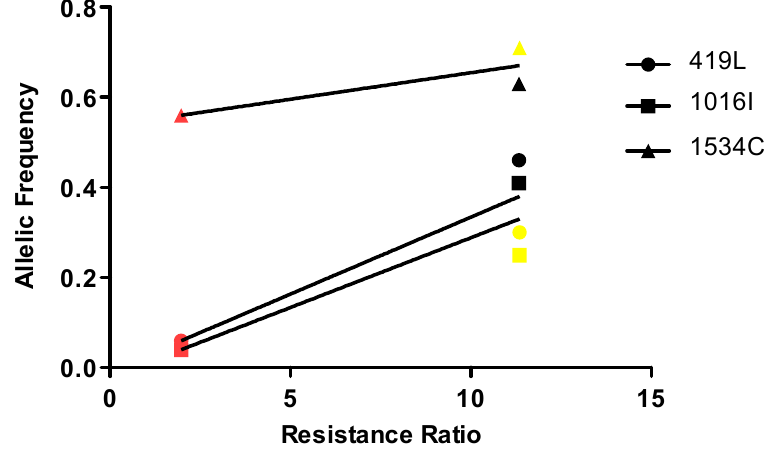
Figure 4. Relationship between resistance ratio (RR) to λ -cyhalothrin and frequency of kdr alleles (419L, 1016I and 1534C) in Aedes aegypti from Colombia. The red, yellow and black symbols represent Bello, Riohacha and Villavicencio mosquito populations, respectively.